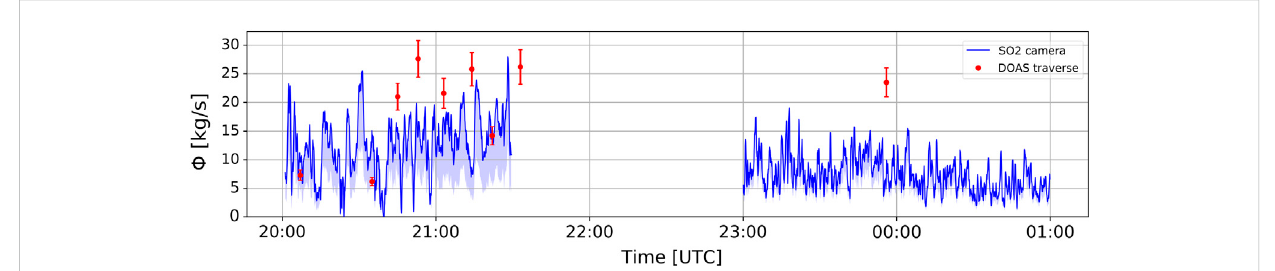
camera data reach 12.9 kg/s at 23:53:15 UTC and 13.8 kg/s at 23:54:30 UTC; the center of the traverse was reached at 23:56: